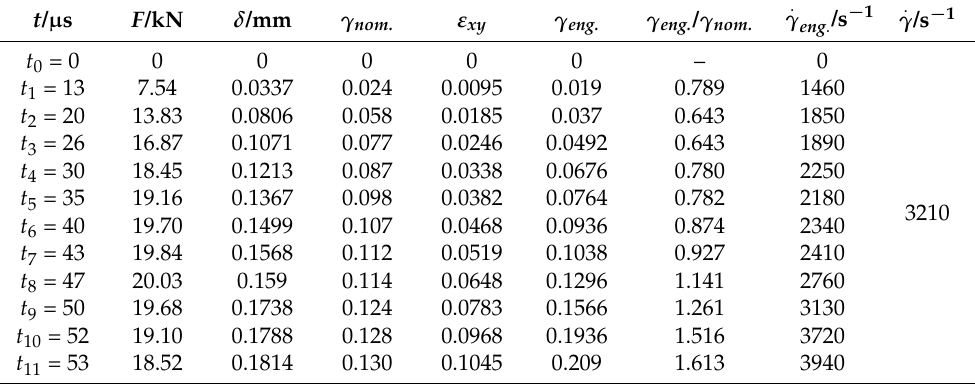
Table 3. Loading, displacement, nominal shear strain and shear strain measured by DIC technique for Ti-55511 alloy deformed at different time, the velocity of the striker bar is 9 m/s. t / µ s γ